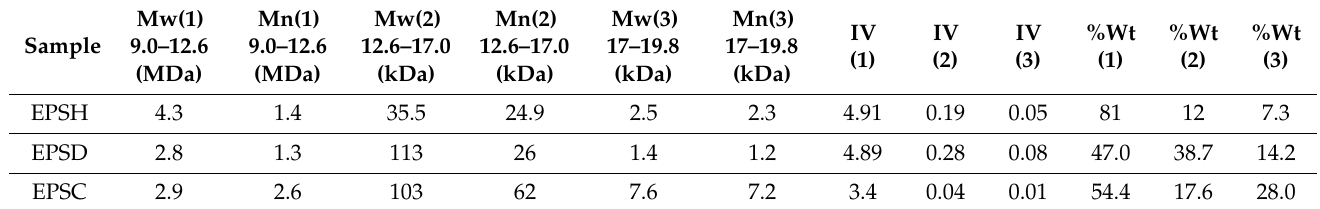
Figure 2. Chromatograms at refractive index detector of EPS based samples: EPSH (blue), EPSD (black), EPSC (red). Table 1. Molecular weight parameters (Mw, Mn), intrinsic viscosity (IV expressed as dl/g), and weight percentage fraction (%Wt) of EPS based samples